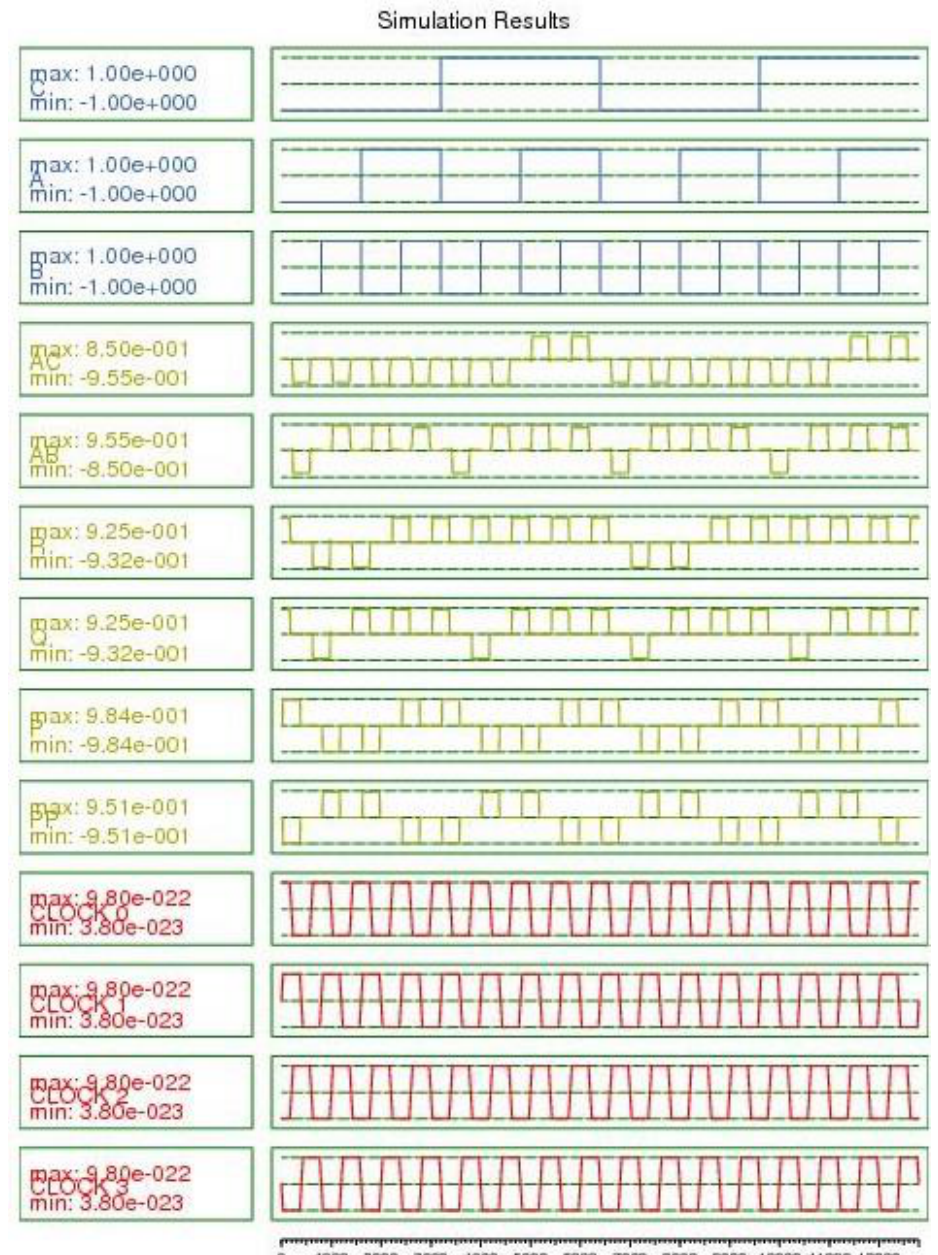
Figure 7. The proposed reversible test circuit simulation results.